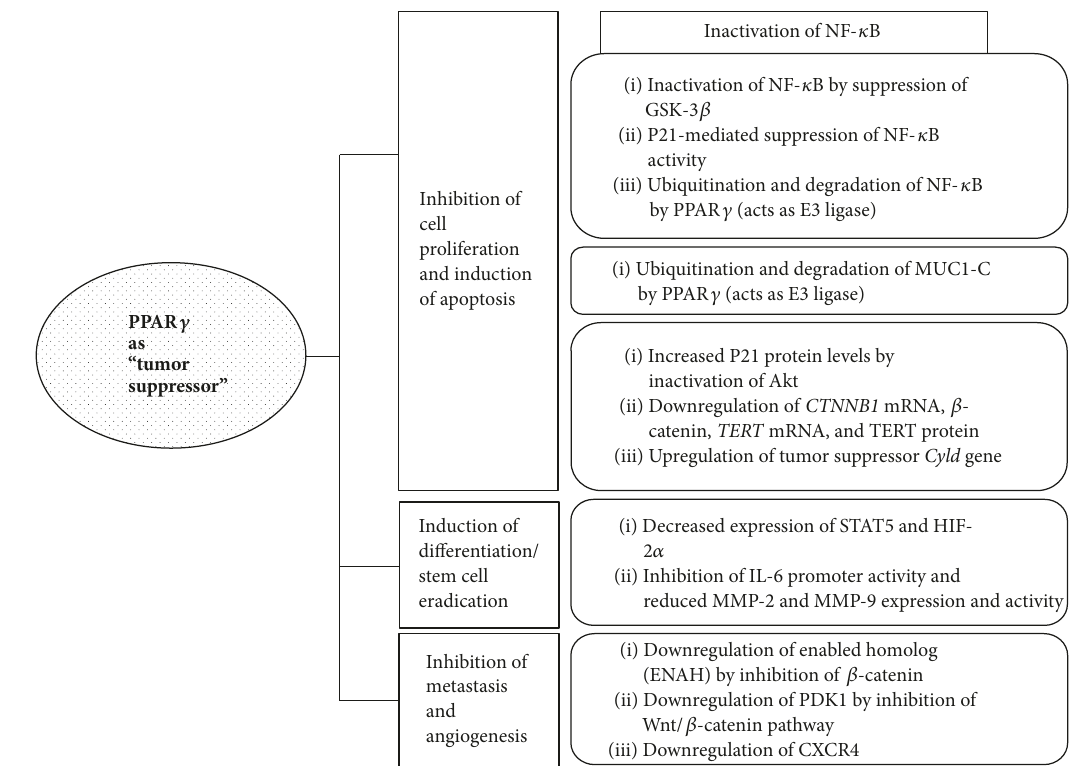
Figure 2: Action mechanisms of PPAR 𝛾 as a tumor suppressor. NF- 𝜅 B, nuclear factor- 𝜅 B; GSK-3 𝛽 , glycogen synthase kinase 3- 𝛽 ; MUC1-C, mucin1-C;TERT,telomerasereversetranscriptase;STAT5,signaltransducerandactivatoroftranscriptionfactor5;HIF-2 𝛼 ,hypoxiainducible factor-2 𝛼 ; IL-6, interleukin-6; PDK1, pyruvate dehydrogenase kinase